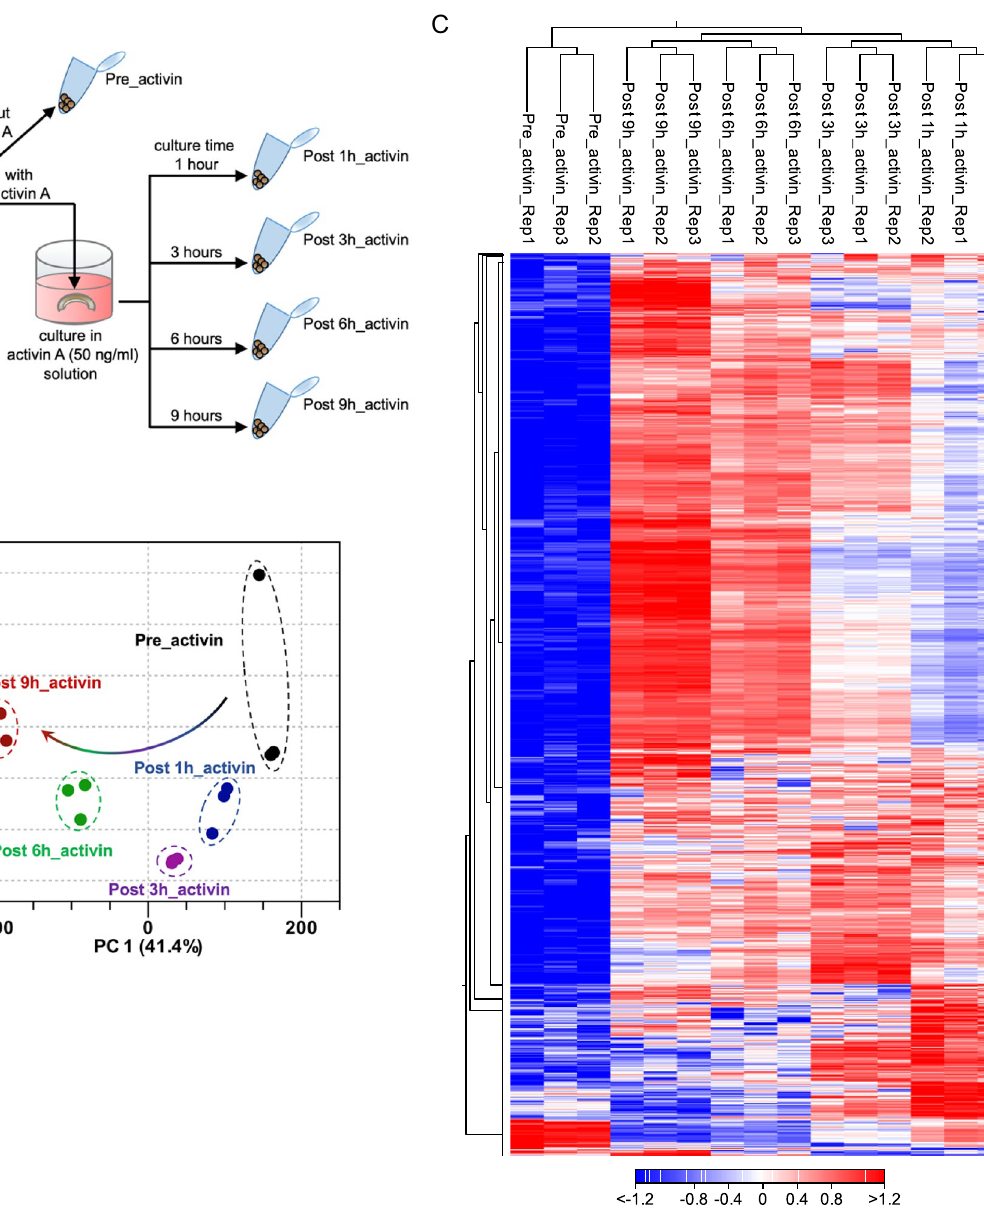
Figure 1. Transcriptomic relationships among AC samples. ( A ) Overview of the sample preparation for a time- course RNA-seq. ACs were collected without activin A treatment (Pre_activin), and after activin A treatment for 1, 3, 6 and 9 h (Post 1h_activin, Post 3h_activin, Post 6h_activin, and Post 9h_activin). ( B ) Principal component analysis (PCA) of ACs. The first two principal components PC1 and PC2 represented 53.7% of the total variance. Each dot denotes a single biological replicate, and dashed circles represent three replicates for each individual sample. Black dot, Pre_activin; blue dot, Post 1h_activin; purple dot, Post 3h_activin; green dot, Post 6h_activin; red dot, Post 9h_activin. ( C ) Hierarchical clustering of the expression profiles between Pre_activin and Post_activin groups. Individual samples are shown in columns, and genes in rows. The upper axis shows the clusters of samples, and the left vertical axis shows clusters of genes. The heatmap represents relative expression (red, high; white, intermediate; blue, low expression). Rep1-3; the biological replicate 1–3. The heatmap was visualized using the CLC Genomic Workbench software 12.0